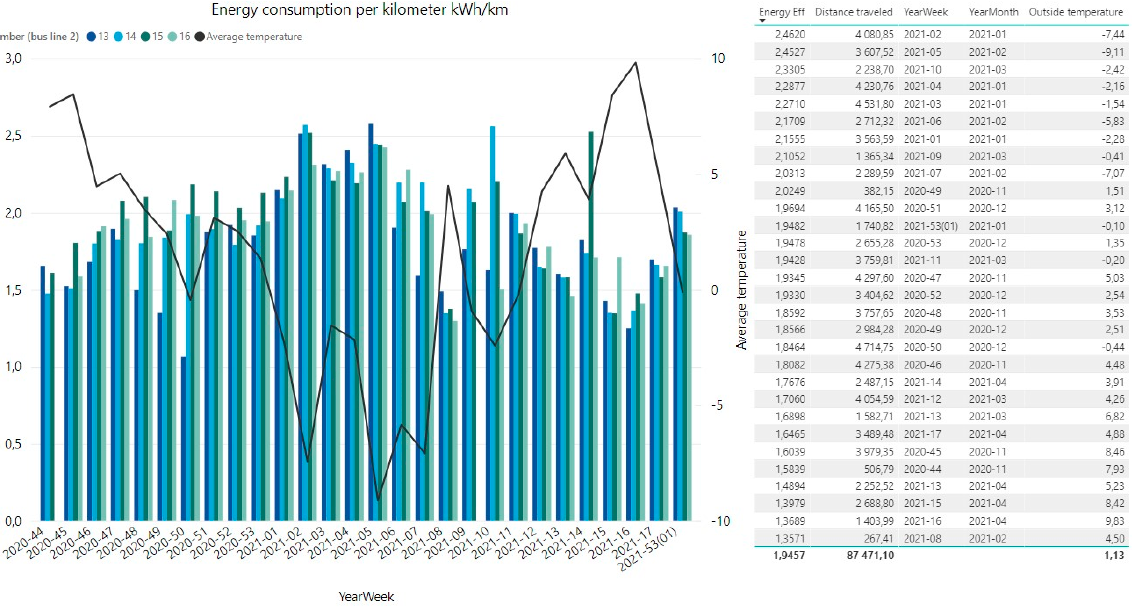
Figure 8. Energy efficiency and outside temperature per week during 1 November 2020–30 April 2021. Disclaimer: The comma is used as a decimal separator instead of a dot because the version of Power BI used in the visualization followed the grammar rules of the Finnish language.